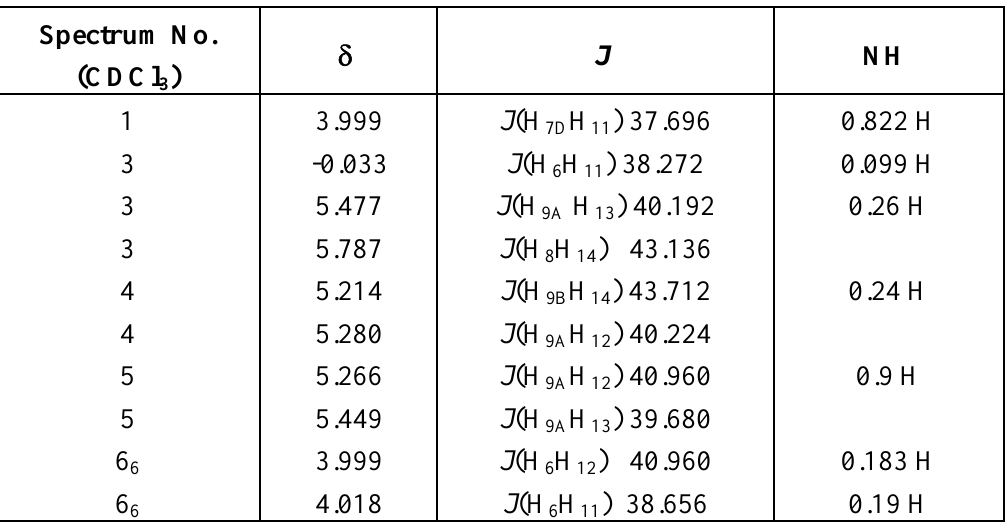
Table 9 . The 1 H-NMR chemical shifts δ [ppm] from TMS and the 1 H- 1 H long – range coupling constants [Hz] of 1